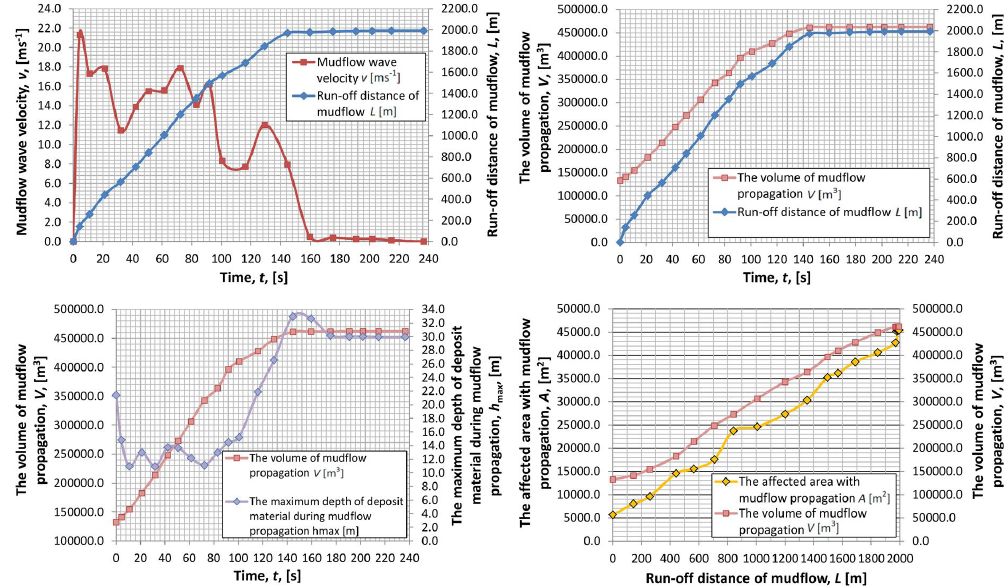
Figure 16. Visualization of dependence of individual output parameters with respect to time and runout distance of mudflow propagation: Simulation 2 with the application of the Hungr erosion